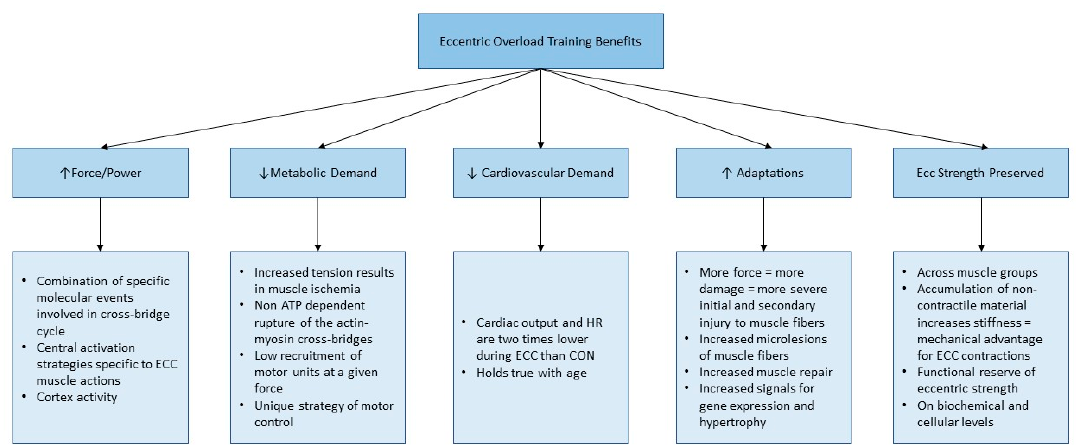
Figure 2. Summary of Eccentric Exercise Benefits on a senior population. The five key benefits of eccentric training on a senior population include increase force and power production, decreased metabolic demand (metabolic efficiency), decreased cardiovascular demand, increased muscular adaptations as well as the fact that eccentric strength is preserved. Information compiled from: [7,26,32–34,41–43,45,46].